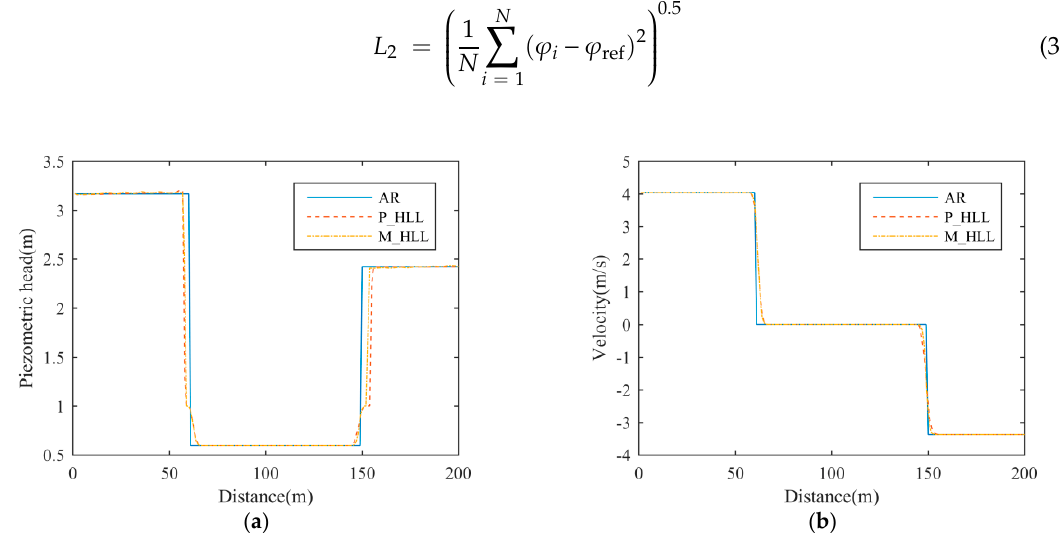
Figure 16. Comparison of the results simulated by P_HLL ( P a = 5 and P b = 0.8), M_HLL ( K a = 1.4 and